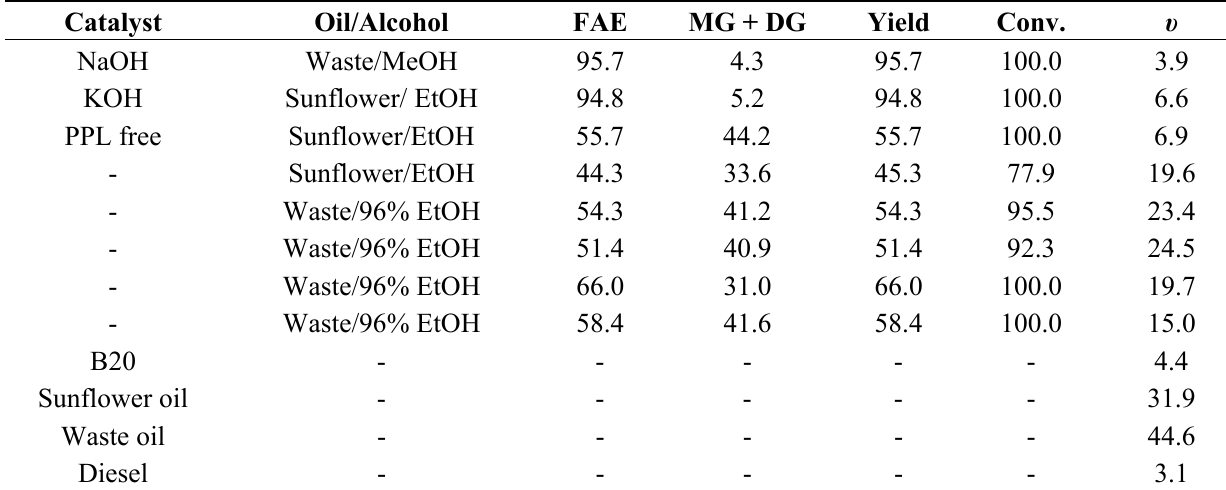
Table 3. Kinematic viscosity values, υ (cSt or mm 2 /s) at 40 °C of various representative biofuel obtained under homogeneous alkaline or enzymatic catalysis as well as under heterogeneous catalysis, using both absolute and 96% ethanol, respectively. Kinematic viscosity of sunflower oil, commercial diesel and a B20 blend obtained from a biofuel ( υ = 15.0) 20% and commercial diesel are also